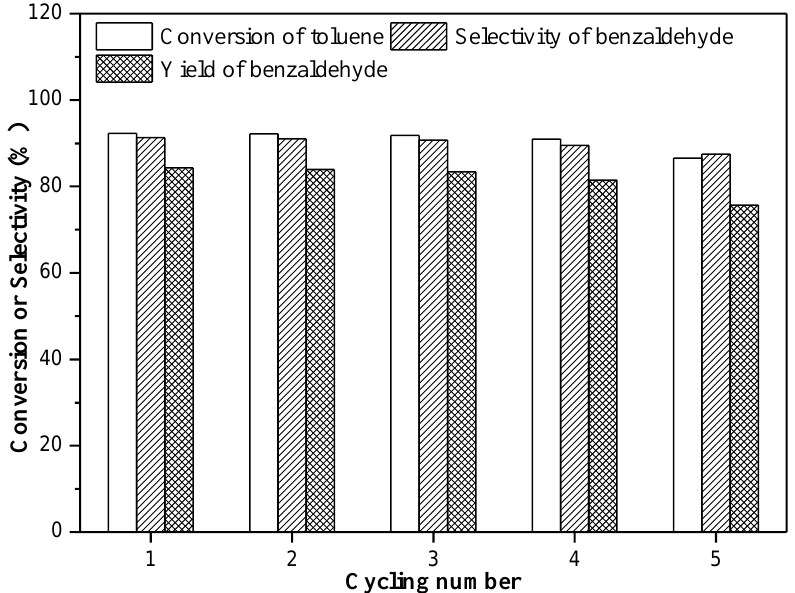
Figure 11. The recycling of Co-ZIF catalyst. Reaction conditions 0.20 g Co-ZIF, 0.500 mmol toluene, 20 mL HFIP, 0.004 g NHPI, 0.12 MPa O 2 , 313 K and 240